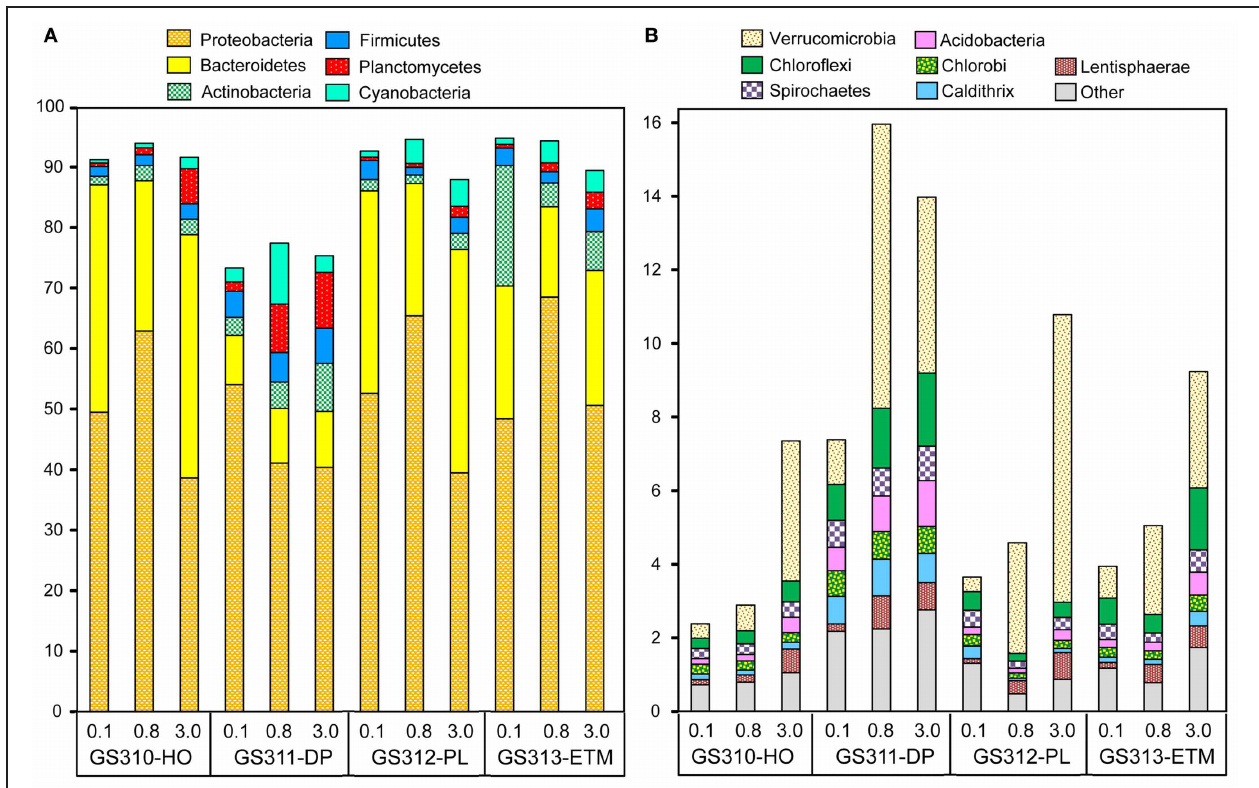
peptides. Sample names are encoded as described in the legend for Figure 3 . (A) Most abundant phyla with values > 5% of total post-QC reads in at least one metagenome; (B) Next-most abundant 10 phyla with values >